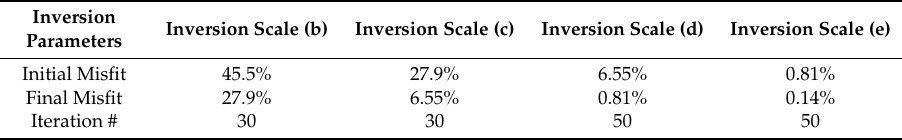
Table 3. The misfit and iteration number for the different inversion scales.